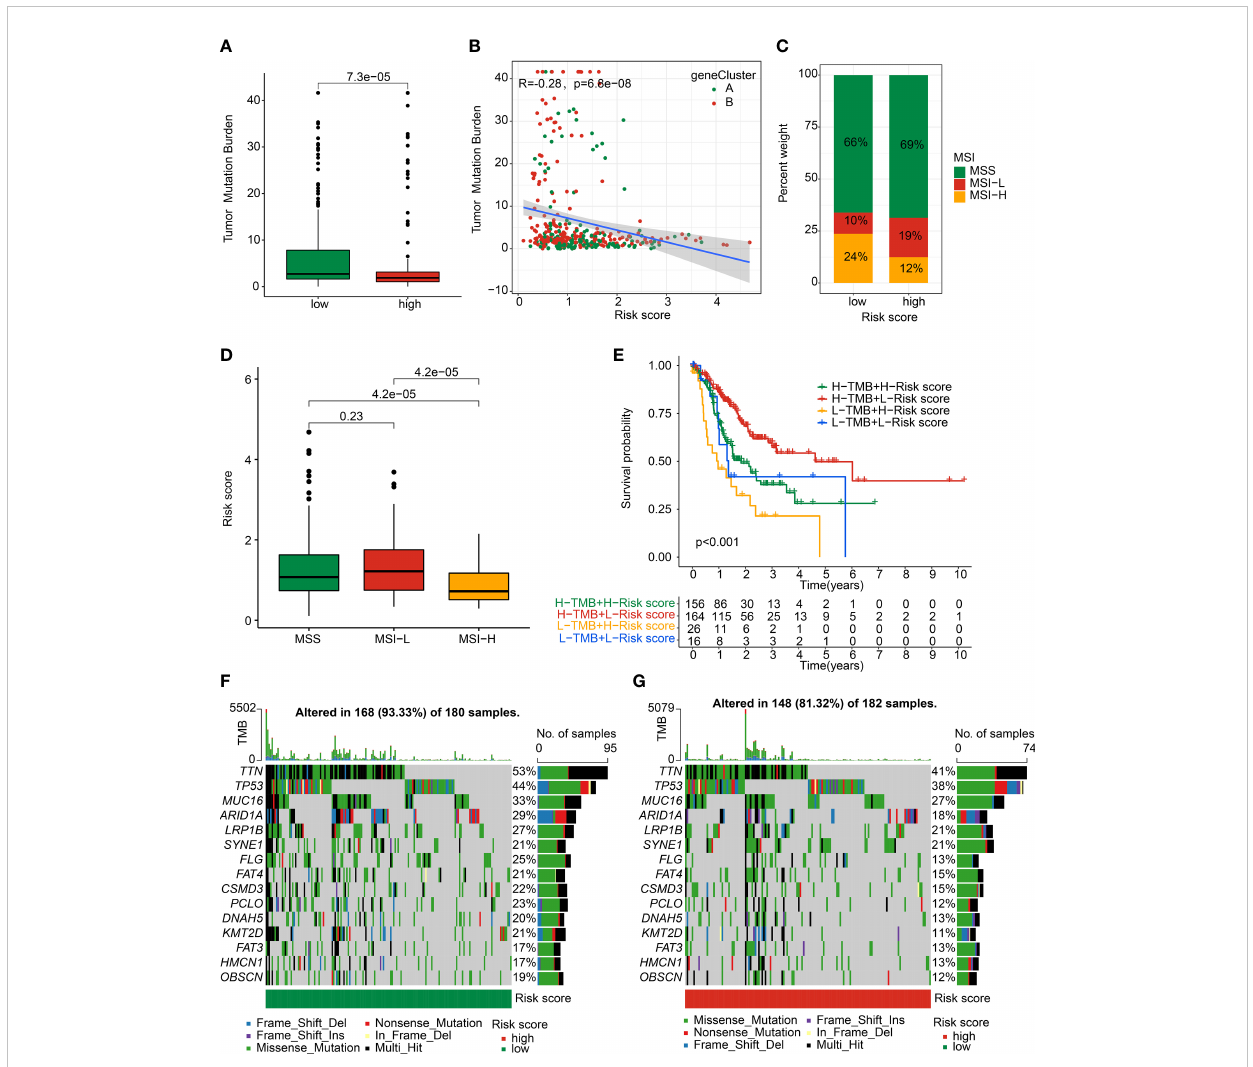
FIGURE 10 Somatic mutation landscape and MSI in GC. (A) TMB analysis. (B) Correlation analysis of risk score and TMB in gene cluster. (C) Percent of MSI in low- and high-risk groups. (D) Distribution of risk score in MSS, MSI-L, and MSI-H. (E) Kaplan-Meier analysis of GC with low- and high-risk scores in L- and H-TMB groups. (F, G) The genetic mutation frequency in low- and high-risk